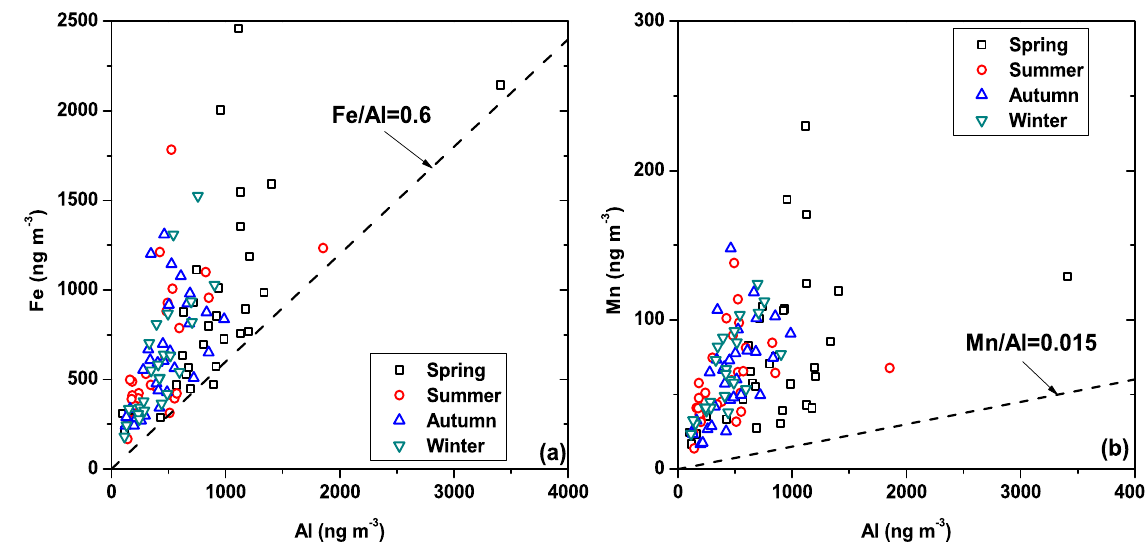
Figure 8. Scatter plots of Fe versus Al and Mn versus Al in PM 2 . 5 of Chengdu.